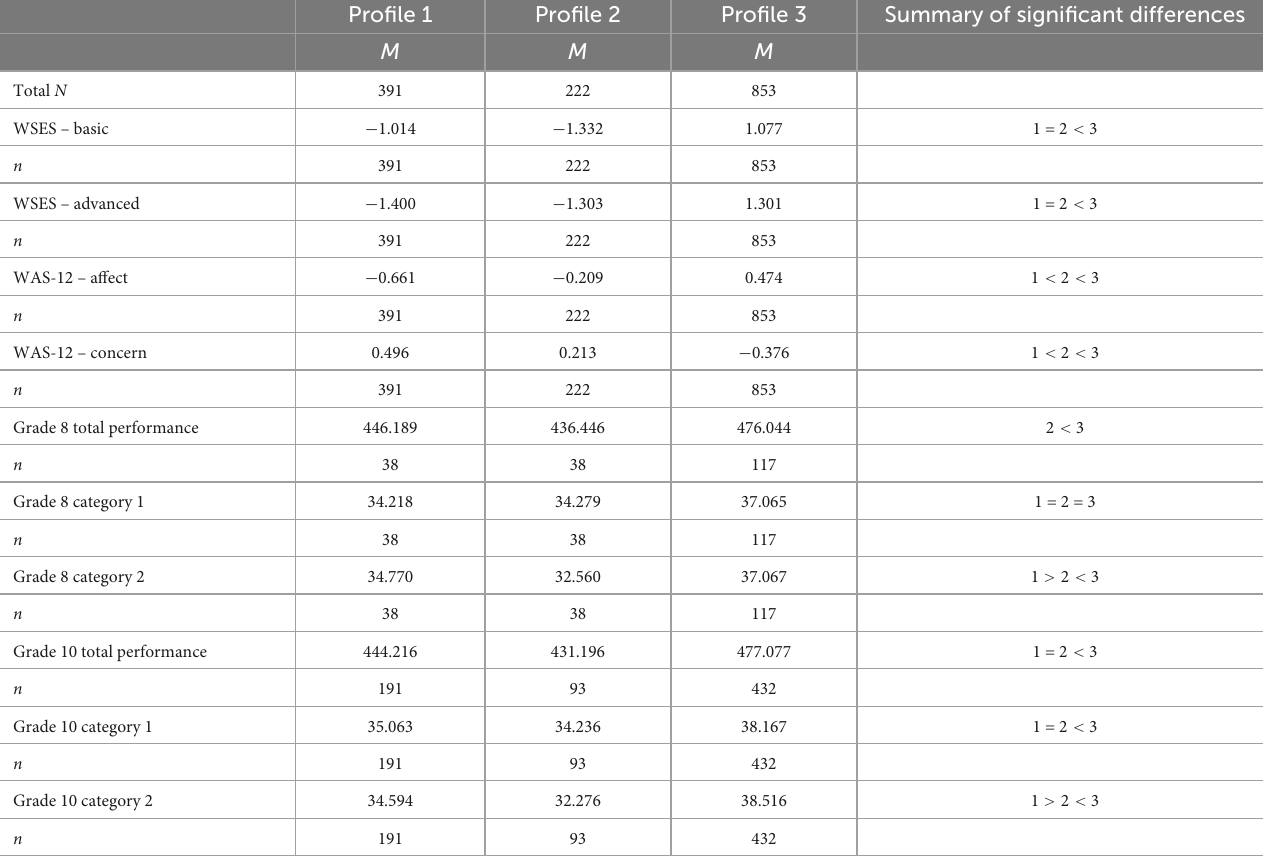
TABLE 10 Bifactor-ESEM LPA outcomes by